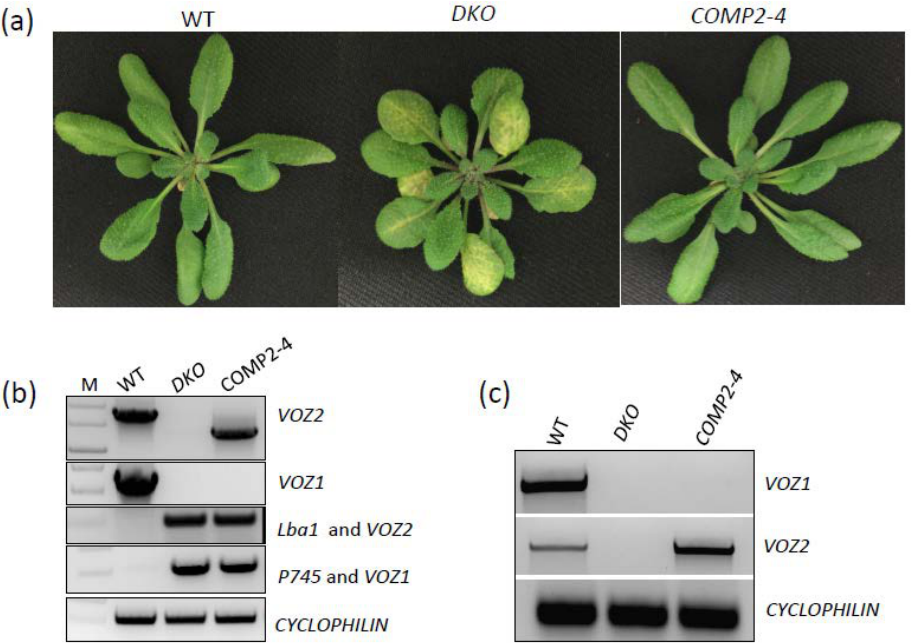
Figure 1. Validation of genotypes used for RNA-Seq. ( a ) Top panel: Phenotype of 30-day-old plants of wild-type (WT), double knockout ( DKO) mutant ( voz1-1 voz2-1 ) and DKO complemented line (COMP2-4) grown at 21 °C under day neutral conditions at 60% humidity. ( b ) Genomic PCR of three genotypes used for RNA-Seq. Top panel (PCR with VOZ2 -specific primers); second panel (PCR with VOZ1 -specific primers); third panel (PCR with T-DNA specific Lba1 and VOZ2 -specific reverse primer); fourth panel (PCR with Tn insertion specific primer P745 and VOZ1-specific forward primer); bottom panel (PCR with CYCLOPHILIN -specific primers). In all cases expected size PCR product was obtained. ( c ) Analysis of expression of VOZ1 (top panel), VOZ2 (middle panel) and CYCLOPHILIN (bottom panel) using sqRT-PCR in 30-day-old seedlings of WT, DKO mutant ( voz1-1 voz2-1 ) and DKO complemented line (COMP2-4).